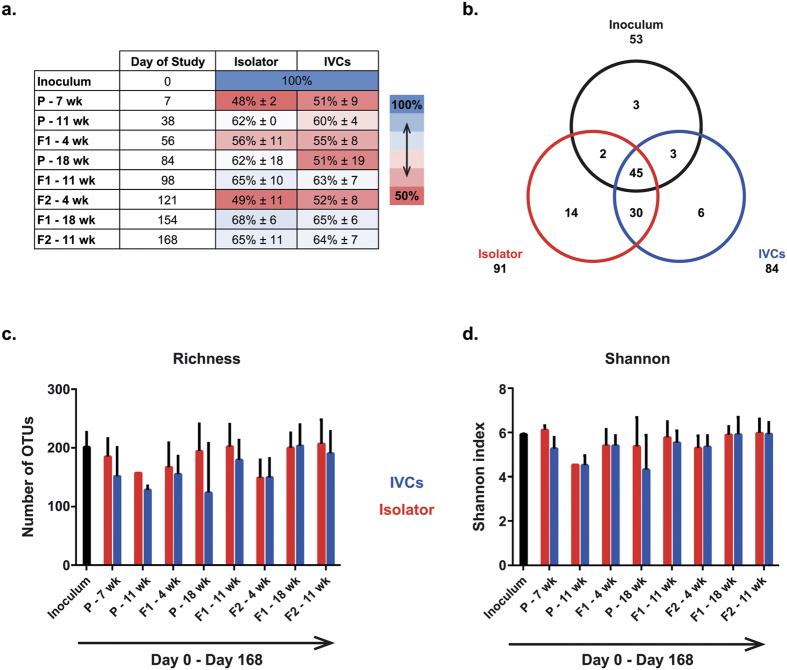
Colonization efficiency and alpha diversity of the microbiota of mice from different generations.(a) Heat map of colonization efficiency of each generation compared to inoculum. Detected taxa on genus level in the inoculum correspond to 100%, and the mean percentage with s.d. in each housing system is shown for each generation and age time point. There were no differences between the housing systems, but colonization efficiency for P at 7 weeks and F1 and F2 at 4 weeks were significantly lower than the other time points in both housing systems (Supplementary Table S1). (b) Venn diagram showing number of unique genus level taxa shared between the housing systems and the inoculum. (c+d) Richness (number of OTUs not summarized to a specific taxonomic level) (c) and Shannon index (d) of inoculum and fecal samples from each generation and age sorted per the timeline of the study (Day 0-Day 168). There were no differences between the housing systems at any time point (t-test; bars are s.d.). P = parent mice inoculated at 6 weeks of age; F1 and F2 = offspring generations born with the microbiota.